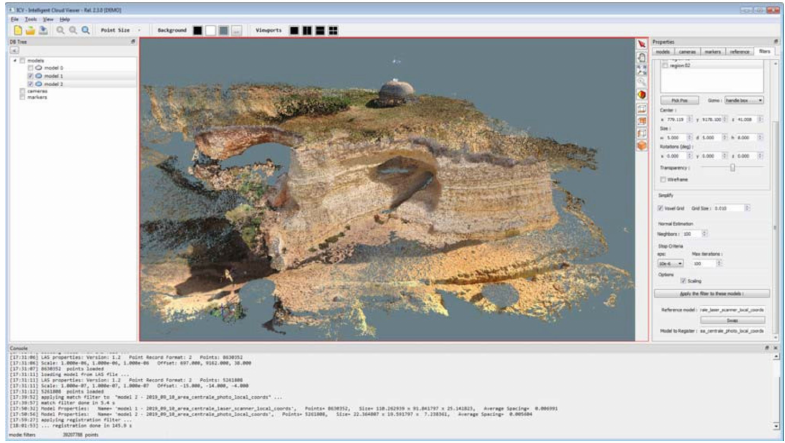
Figure 20. Result of fine registration between TLS and terrestrial photogrammetry.